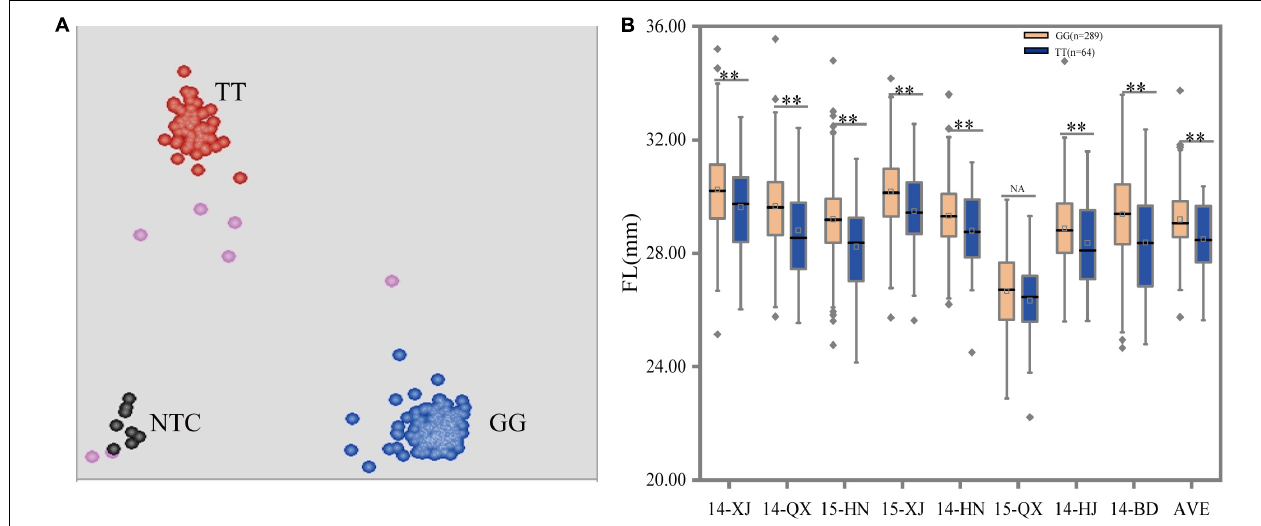
FIGURE 2 | Scatterplots and box plots for marker D11_24030087 (G/T). (A) Clusters of accessions on the X - (FAM) and Y - (HEX) axes. The red, blue, pink, and black dots represent the homozygous, missing or failed data, and non-template control, respectively. (B) Allele effects were measured using different phenotypic data under eight environments. ∗∗ , and NA indicate significant levels at P < 0.01 and no significant difference, respectively.